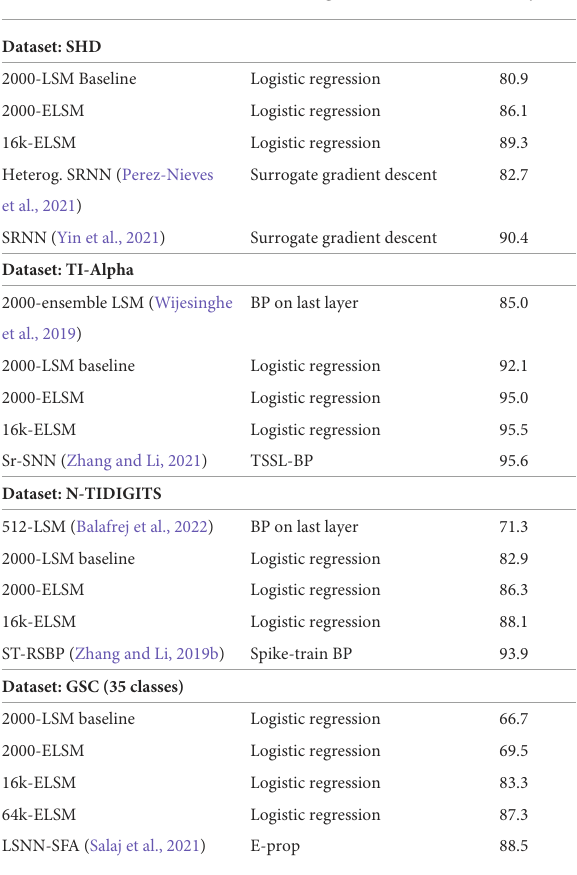
TABLE 5 Comparison of the baseline LSM to the ELSM and the state-of-the art in spiking neural networks across different data sets.